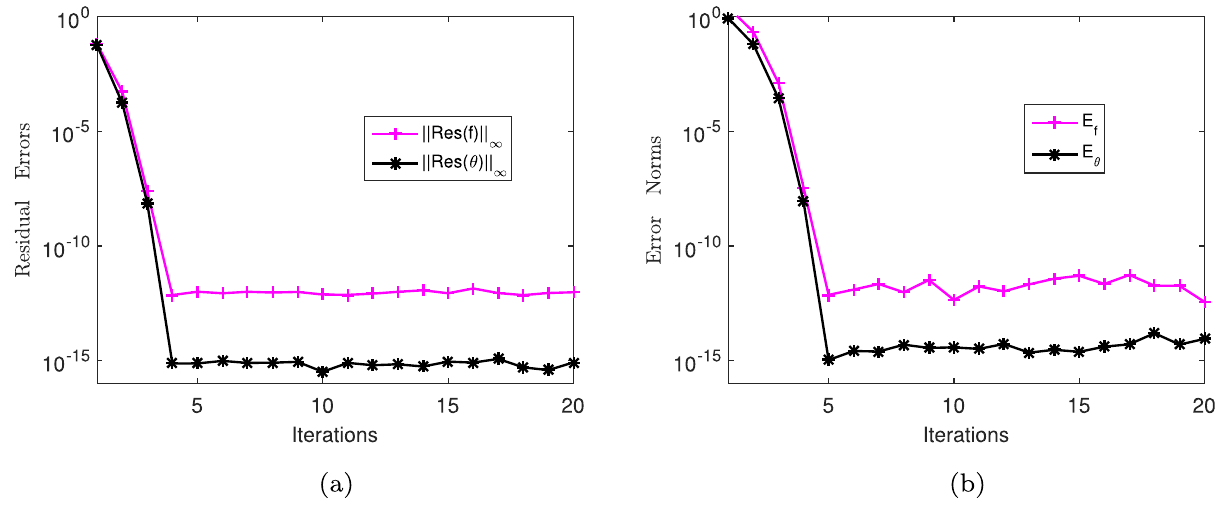
Figure 5: Behaviour of ( a ) residual errors ( b ) and error norms against iterations when = N 2 η and = (cid:2) 60